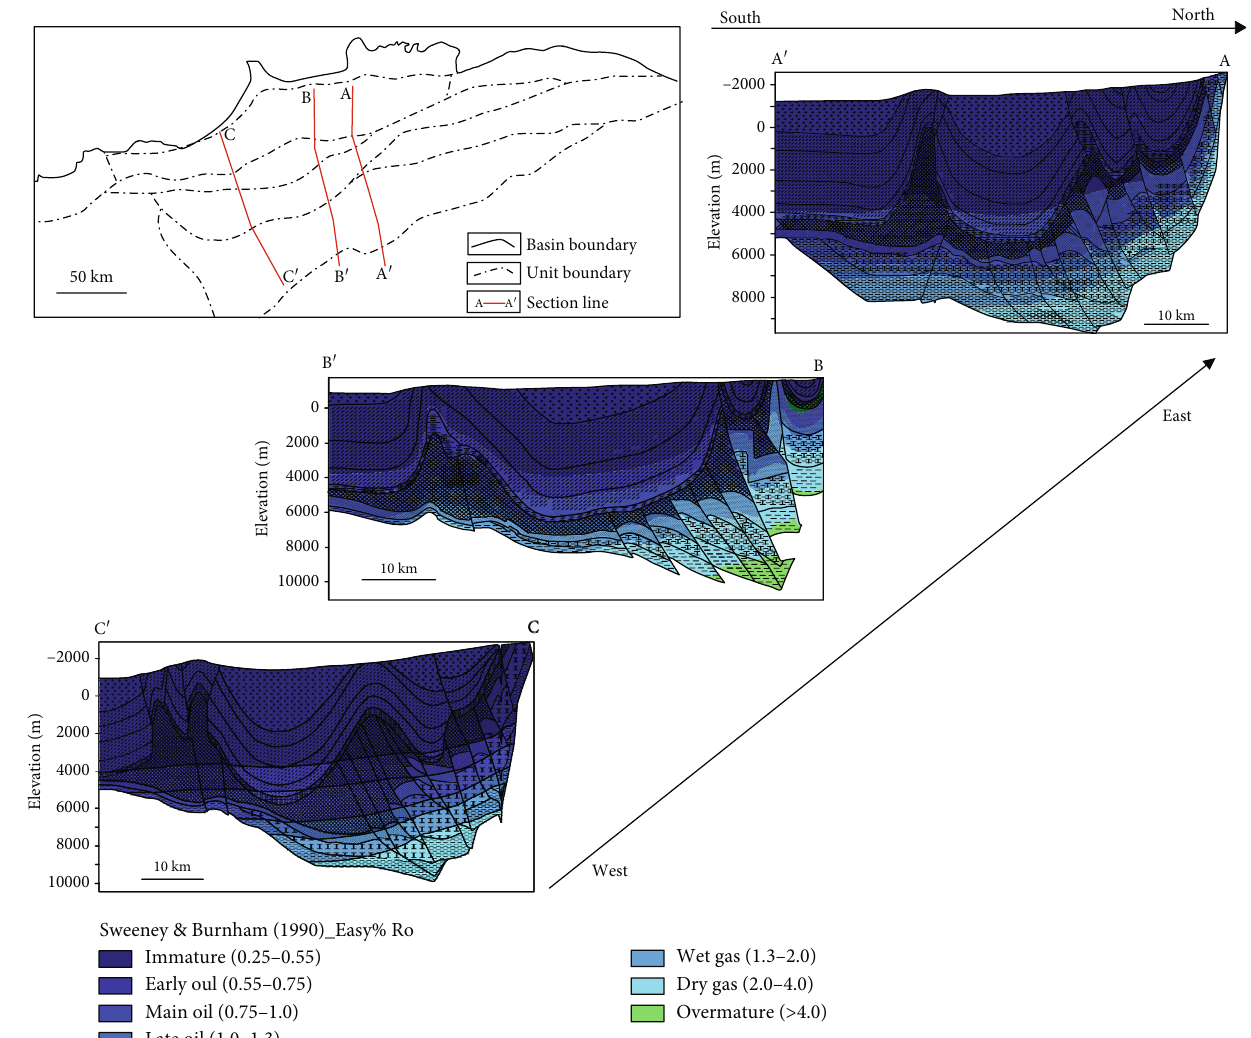
Figure 9: Contrast of thermal modeling results between three north-south geological pro fi